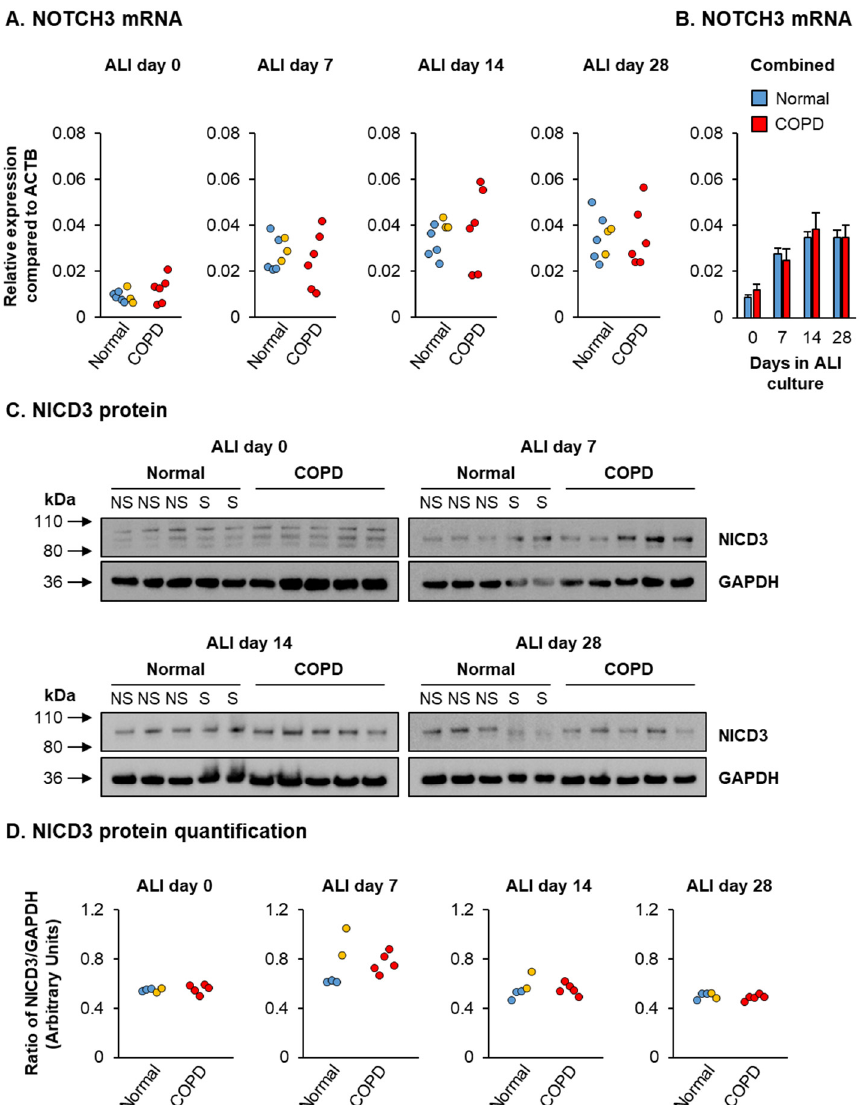
Figure 7. NOTCH3 expression and activation during ALI differentiation. Normal ( n = 5 nonsmoker donors (blue circles) and n = 3 smoker donors (orange circles)) and COPD ( n = 6 donors (red circles)) HBECs were cultured on ALI for 28 days to differentiate into a mucociliary epithelium containing basal, club, goblet and ciliated cells. ( A , B ) qPCR analysis of NOTCH3 expression as a function of time during ALI culture (days 0, 7, 14 and 28). ( A ) Data presented for individual HBEC donors at each time point. ( B ) Data presented as mean expression for normal ( n = 8) and COPD ( n = 6) HBEC donors at each time point. Error bars indicate SEM. ( C ) Western blot analysis of NICD3 protein levels in normal ( n = 3 nonsmoker donors (blue circles) and n = 2 smoker donors (orange circles)) and COPD ( n = 5 donors (red circles)) HBECs as a function of time during ALI culture (days 0, 7, 14 and 28). GAPDH was used as loading control. ( D ) Quantification of western blot analysis. Data presented as ratio of NICD3/GAPDH protein levels for each HBEC